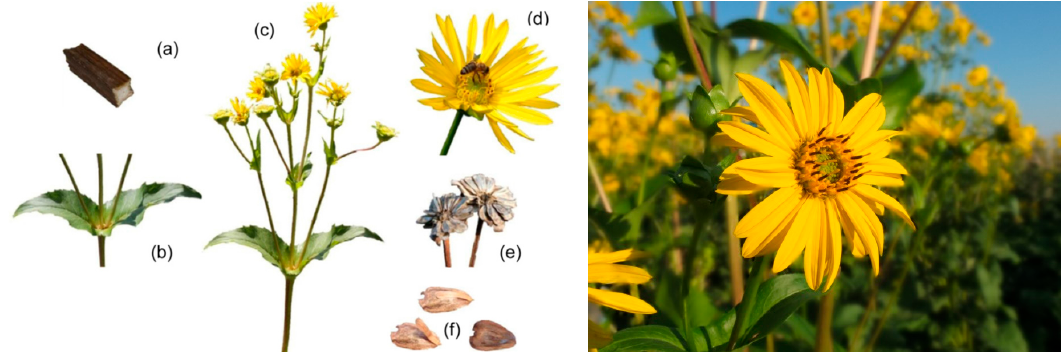
Figure 6. Left : Silphium perfoliatum L. ( a ) quadrangular stalk, ( b ) cup-shaped leaf axil, ( c ) branched stalk with flower buds and flower heads, ( d ) flower head with tubular and ligulate ray flowers, ( e ) mature inflorescence, and ( f ) fruits. Reproduced with permission from [111], Elsevier, 2019. Right : Silphium perfoliatum L. cultivated at the Campus Klein-Altendorf, Rheinbach, Germany. Copyright 2019, Georg Völkering.